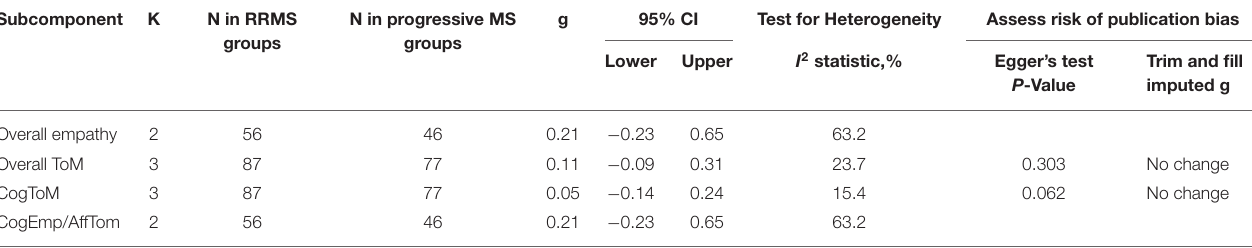
TABLE 6 | Mean effects for ToM and empathy subcomponents comparing participants with relapsing-remitting multiple sclerosis against progressive multiple sclerosis and tests for publication bias. Subcomponent